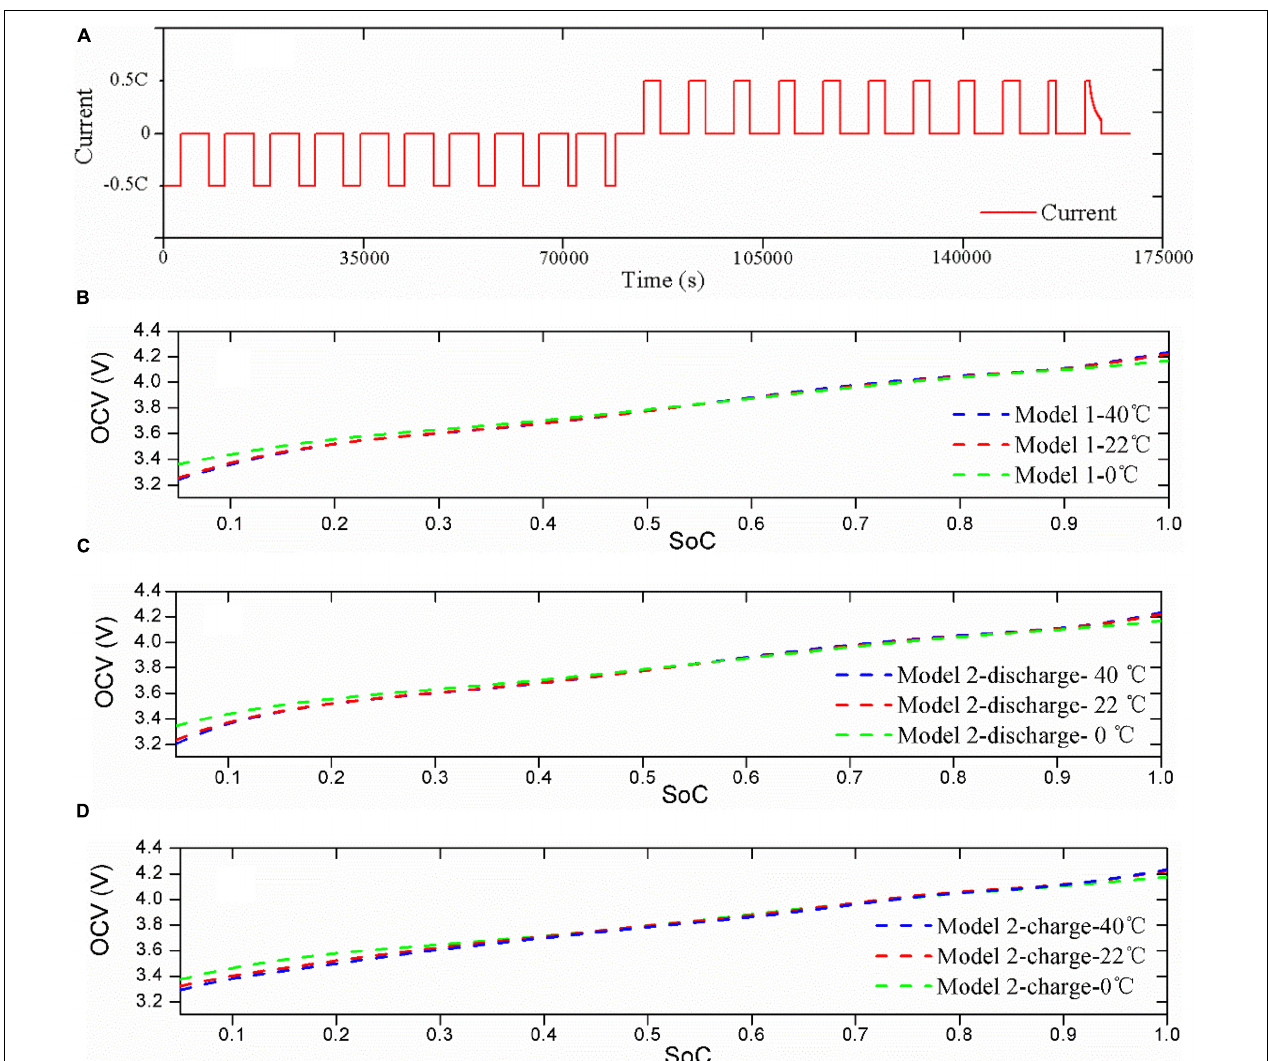
FIGURE 2 | IO testing current profile and results. (A) Current profile; (B) Model 1; (C) Model 2 (discharge); (D) Model 2